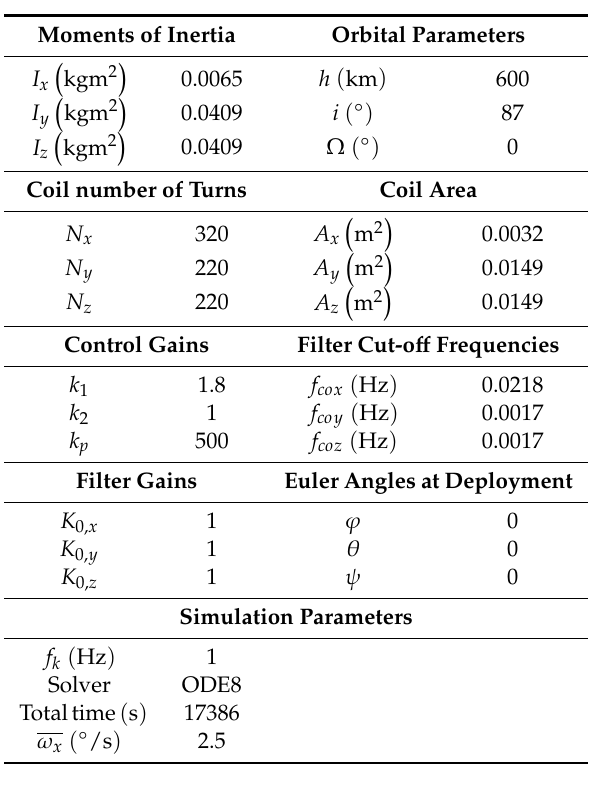
Table 2. Angular rates at deployment for Test Case 1 and Test Case